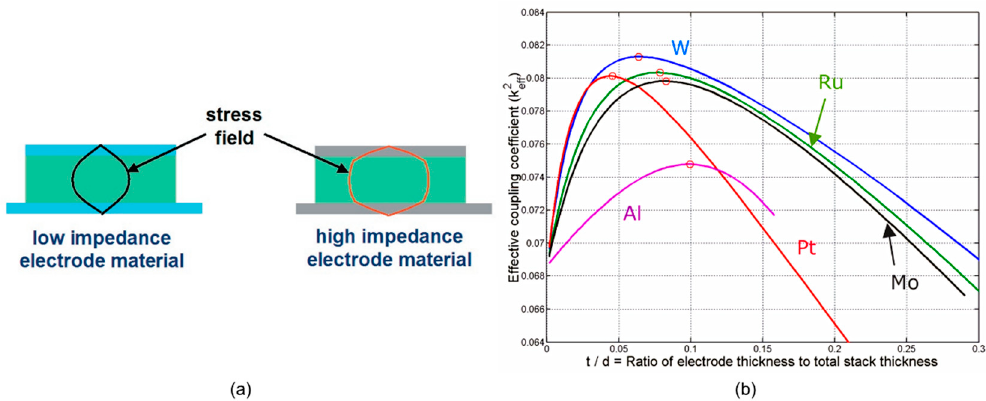
Figure 5. ( a ) Stress field distribution throughout a bulk acoustic wave (BAW) resonator with low impedance and high impedance electrode materials, reproduced with permission from [12]. ( b ) Relationship between k eff2 and the ratio of electrode thickness to total stack thickness for an AlN resonator with different electrode materials, reproduced with permission from [14].